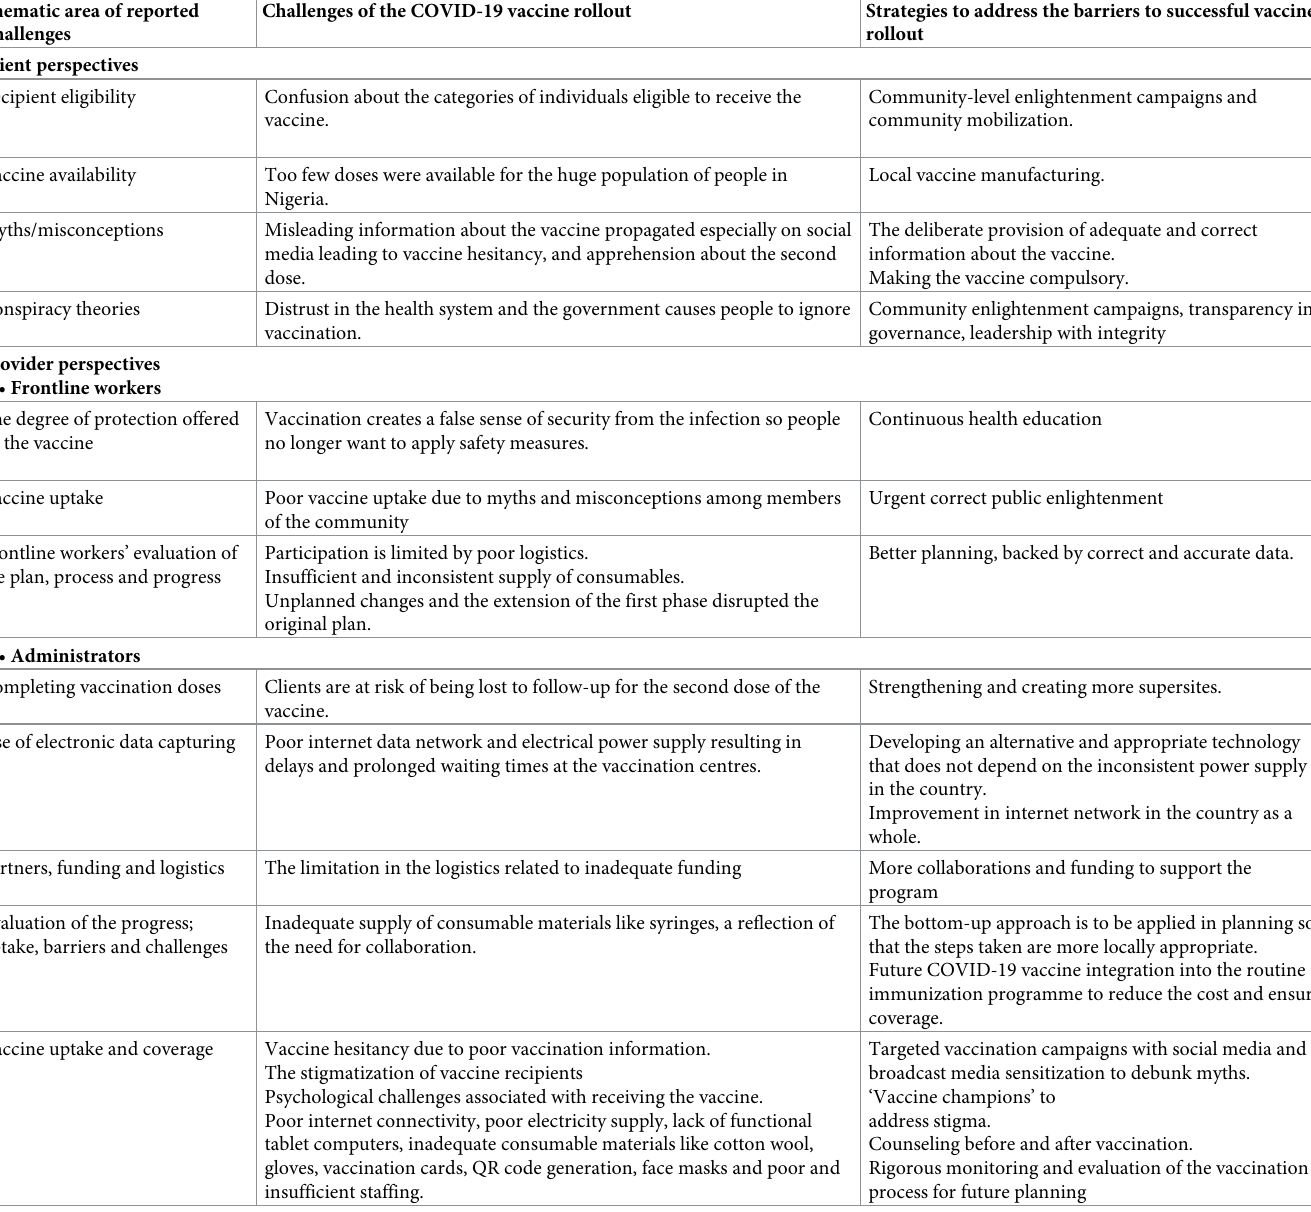
Table 2. Summary of client and provider perspectives on the challenges of the COVID-19 vaccine rollout plan, process and progress and strategies to address the barriers to successful vaccine